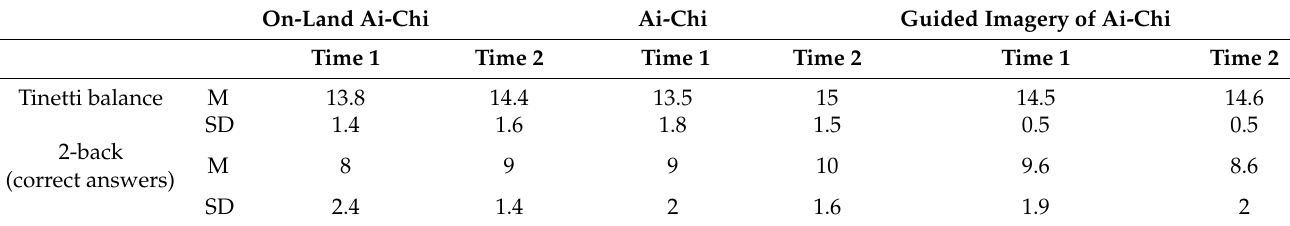
Table 2. Means and standard deviations of all